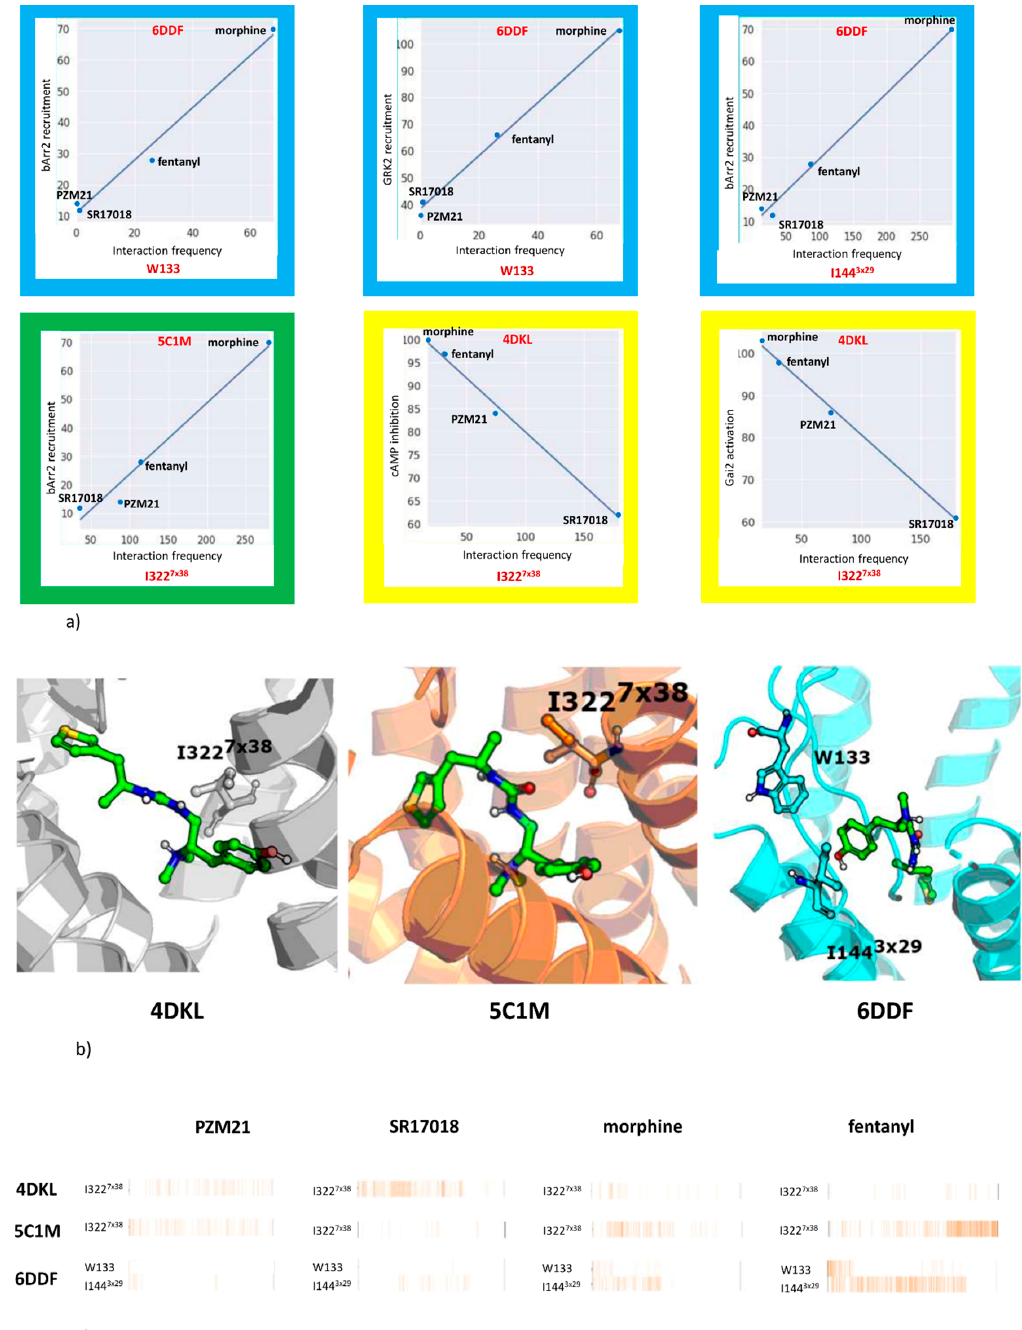
Figure 7. ( a ) Correlation charts between the interaction frequency and outcome of the in vitro experiments (cases with the highest correlation are presented with the Pearson correlation coefficients above 0.98) with frames’ color referring to particular crystal structure—yellow: 4DKL, green: 5C1M, blue: 6DDF; ( b ) indication of residues with the highest correlation presented in ( a ), ( c ) ligand–protein interaction diagrams obtained during MD simulations for residues presented in ( a ).